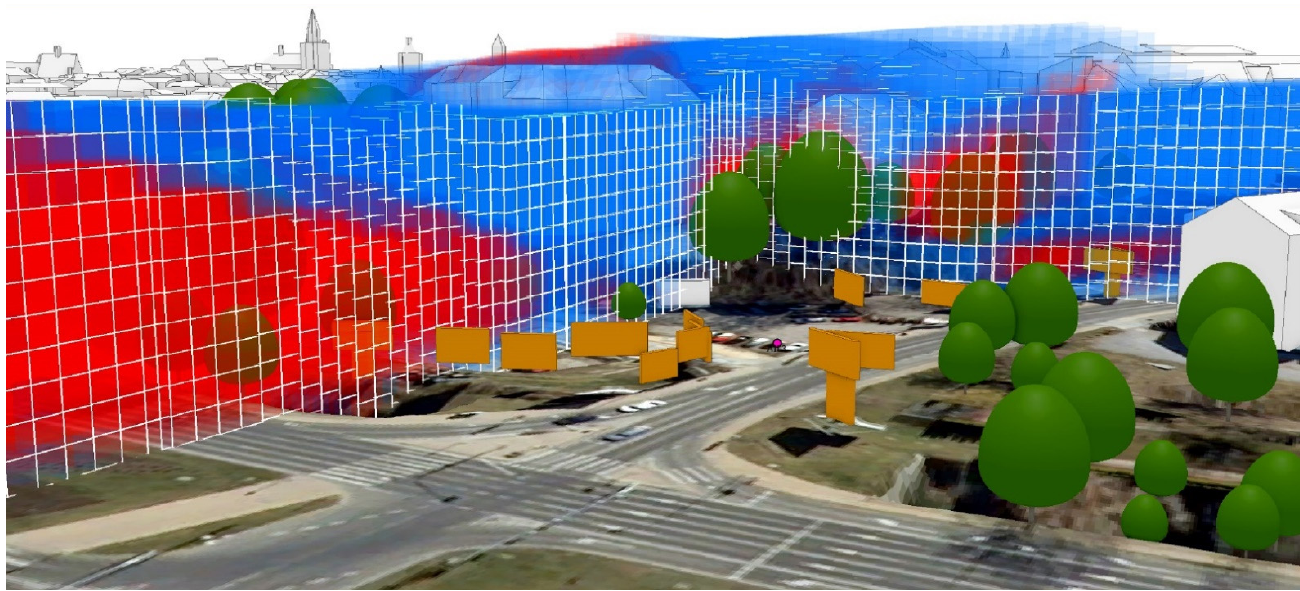
Figure 10. The view volume subsets of area “A” in the OOHb scenario: the VVV (blue) and extensive red volume of obstructed view; the Czechówka river valley view is fully covered from A1L3 observer position.